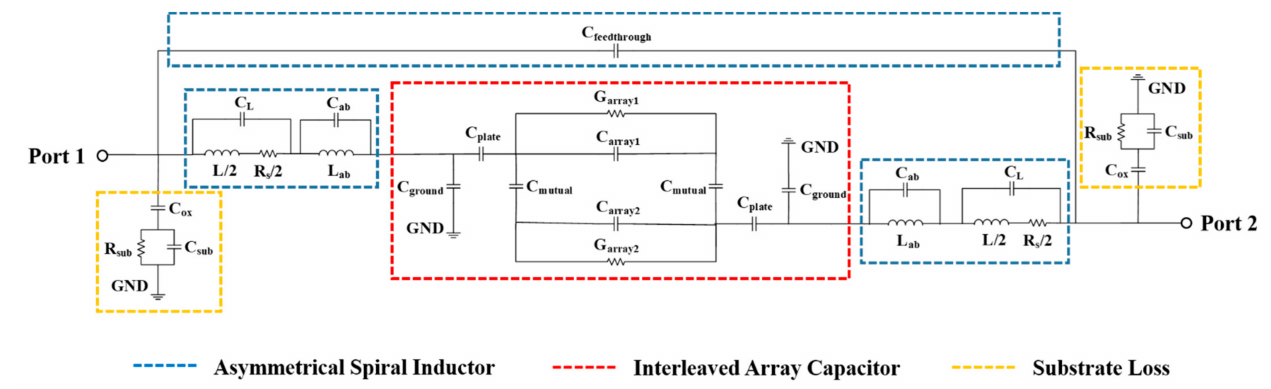
Figure 6. Equivalent circuit of the proposed